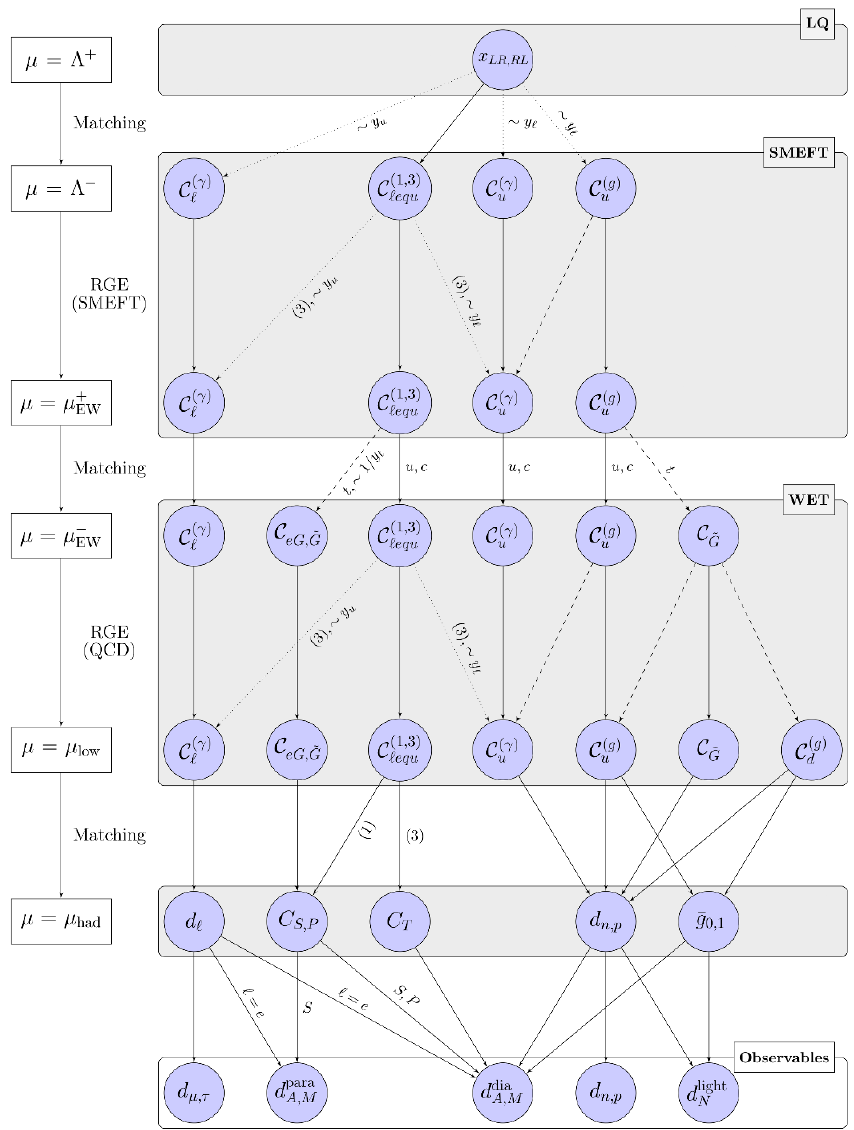
Figure 3 . Summary of the RGE and matching contributions induced by the R 2 or S 1 leptoquark interactions (with x LR;RL ! y LL;RR for the latter) to the e(cid:11)ective CP-odd operators at lower energies, and (cid:12)nally to EDMs of various systems. WET stands for the weak e(cid:11)ective theory below the electroweak scale. (cid:22) low denotes a generic scale (cid:24) GeV; in principle, there are additional matching steps at (cid:22) b (which is negligible in this application) and (cid:22) c , discussed in the